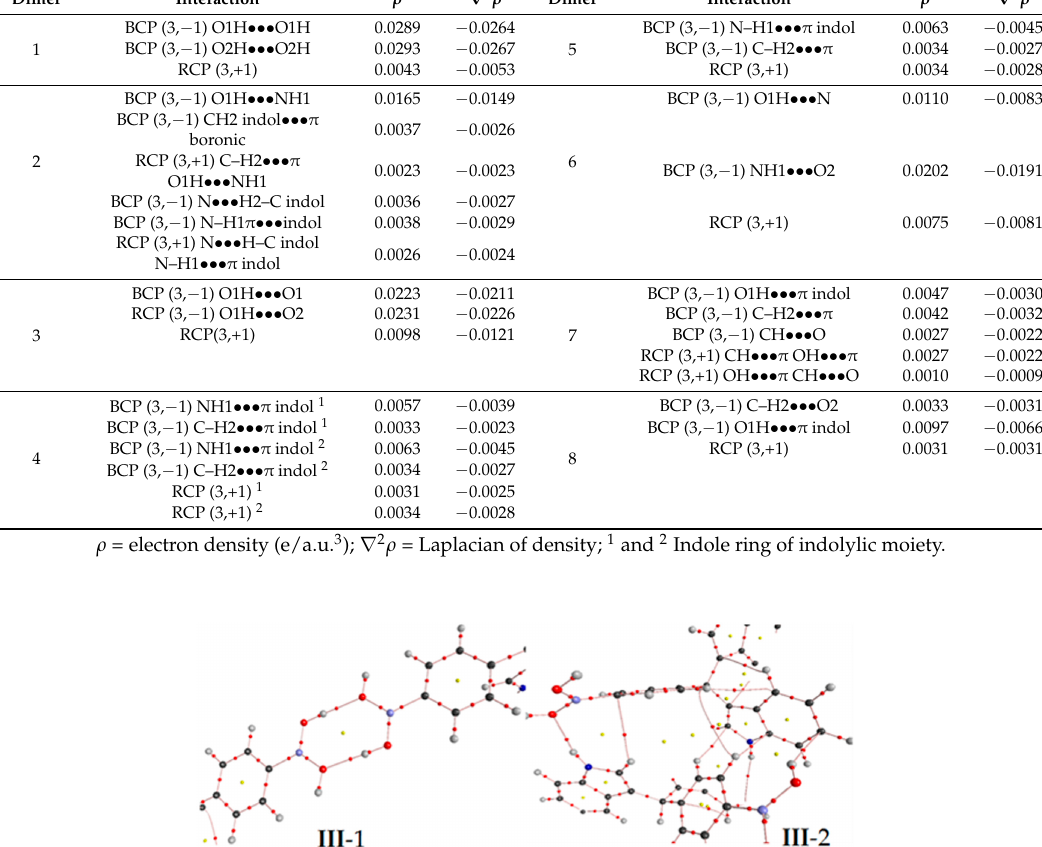
Table 7. Values of electronic density and the square Laplacian of density for the dimers.